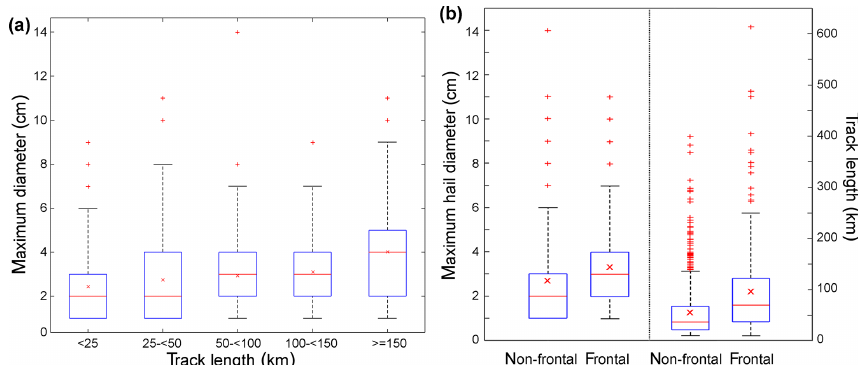
Figure 5. Boxplots showing (a) HS track lengths vs. maximum hail diameter according to ESWD reports and (b) maximum diameter (left) and track length (right) for HS events with or without a synoptic-scale cold front. Indicated in the boxplots are the interquartile range (blue box), median and mean values (red line and red x), and upper and lower 25% percentile ± interquartile range × 1.5 (black lines); data points outside of this range are marked as outliers (red crosses).